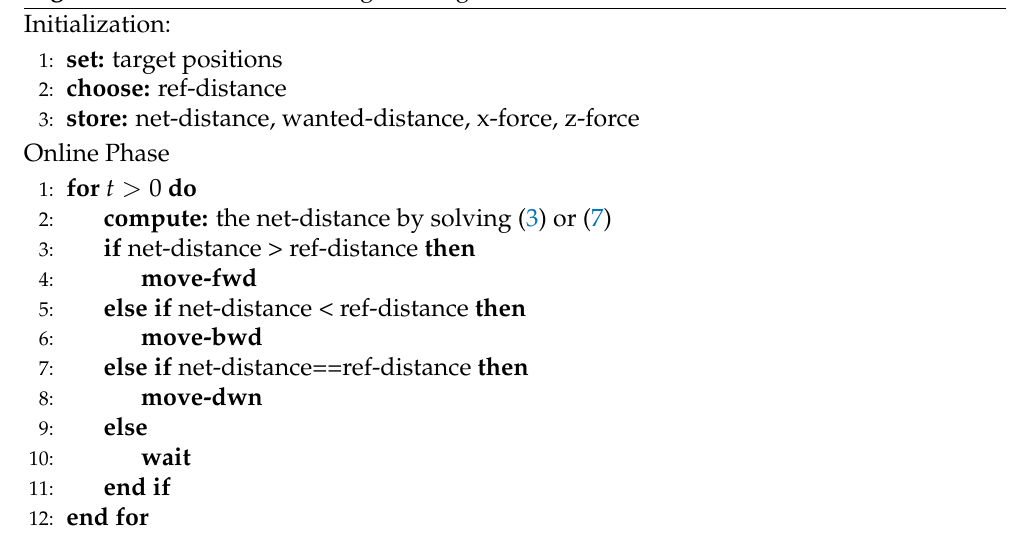
Algorithm 3 Control and Navigation